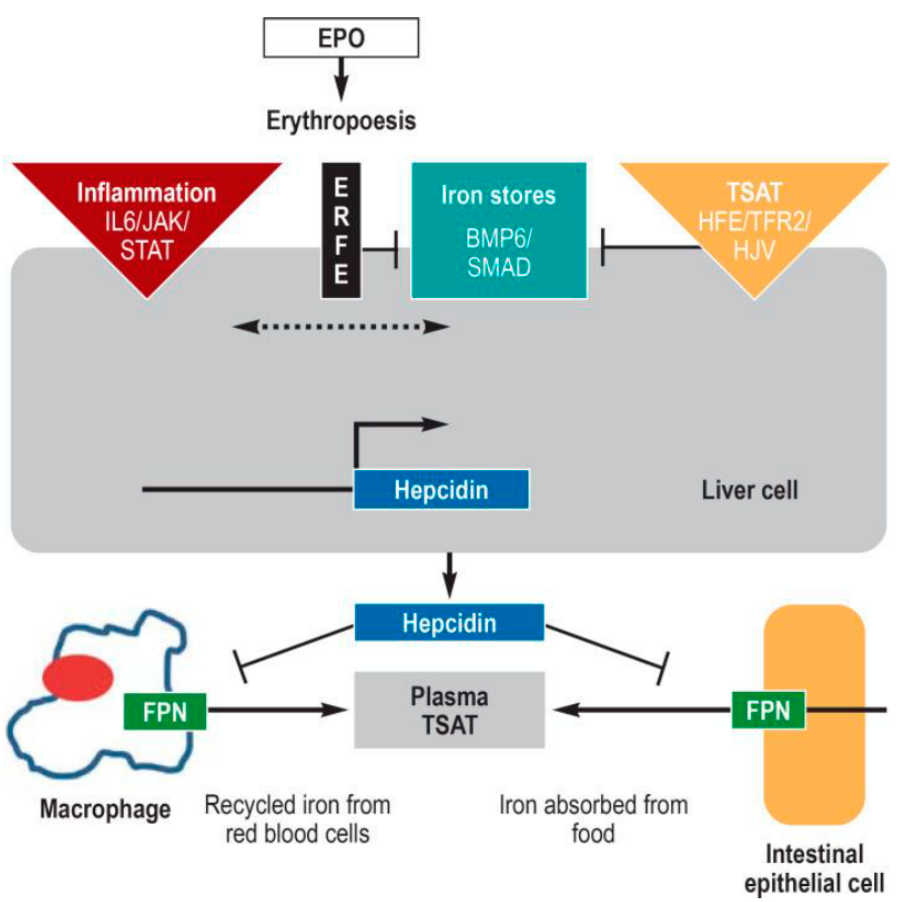
Figure 2. The 25-residue peptide hormone, hepcidin, produced by the liver, is the central regulator of systemic iron metabolism. When hepcidin is released into the circulation, it binds to the iron exporter, ferroportin, resulting in internalisation and degradation of ferroportin, thereby preventing the release of iron from duodenal enterocytes and macrophages of the reticuloendothelial system. Hepcidin expression is controlled by several factors: (i) the amount of available iron, represented by body iron stores (centre) and transferrin saturation [TSAT] (right); (ii) inflammation, essentially via the proinflammatory cytokine, Interleukin 6 [IL6] left); and (iii) the iron requirement for erythropoiesis (centre). Replete iron stores increase the amount of the cytokines BMP2 and 6 (bone morphogenic protein 2 and 6) which, together with the cofactor hemojuvelin (HJV), activates the BMP/SMAD signaling pathway, resulting in hepcidin induction. In inflammation-related functional iron deficiency, hepcidin expression is increased via the JAK/STAT signaling pathway. As a function of the functional iron deficiency, the kidney produces erythropoietin [EPO], which increases erythropoiesis. The erythroid precursor cells continue to produce erythroferron [ERFE], which inhibits the BMP/SMAP pathway, decreasing hepcidin expression. Abbreviations not defined above HFE, high iron; JAK Janus kinase; STAT, signal transducers and activators of transcription; SMAD, small-body-size mothers against decapentaplegic homolog 1; TFR2 transferrin receptor 2